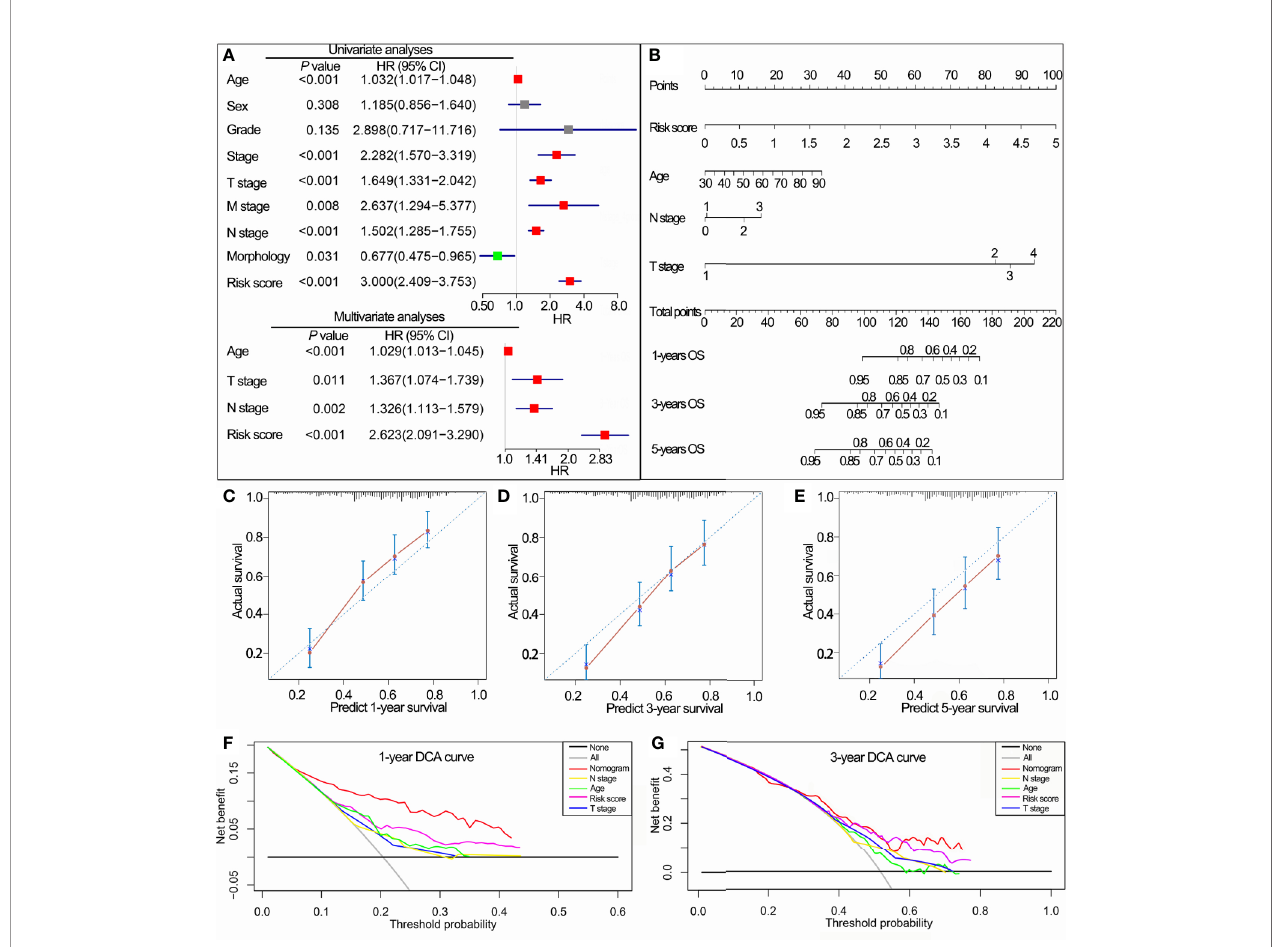
FIGURE 7 | Construction of the nomogram based on the IPS in TCGA data set. (A) Univariate and multivariate Cox analyses indicated that the IPS was signi fi cantly associated with OS. (B) Nomogram for predicting the probability of 1-, 3-, and 5-year OS. (C – E) Calibration plots of the nomogram for predicting the probability of 1-, 3-, and 5-year OS. (F, G) DCA of the nomogram predicting 1- and 3-year OS. IPS, immune prognostic signature; TCGA, The Cancer Genome Atlas; OS, overall survival; DCA, decision curves analyses; HR, hazard ratio; CI, con fi dence